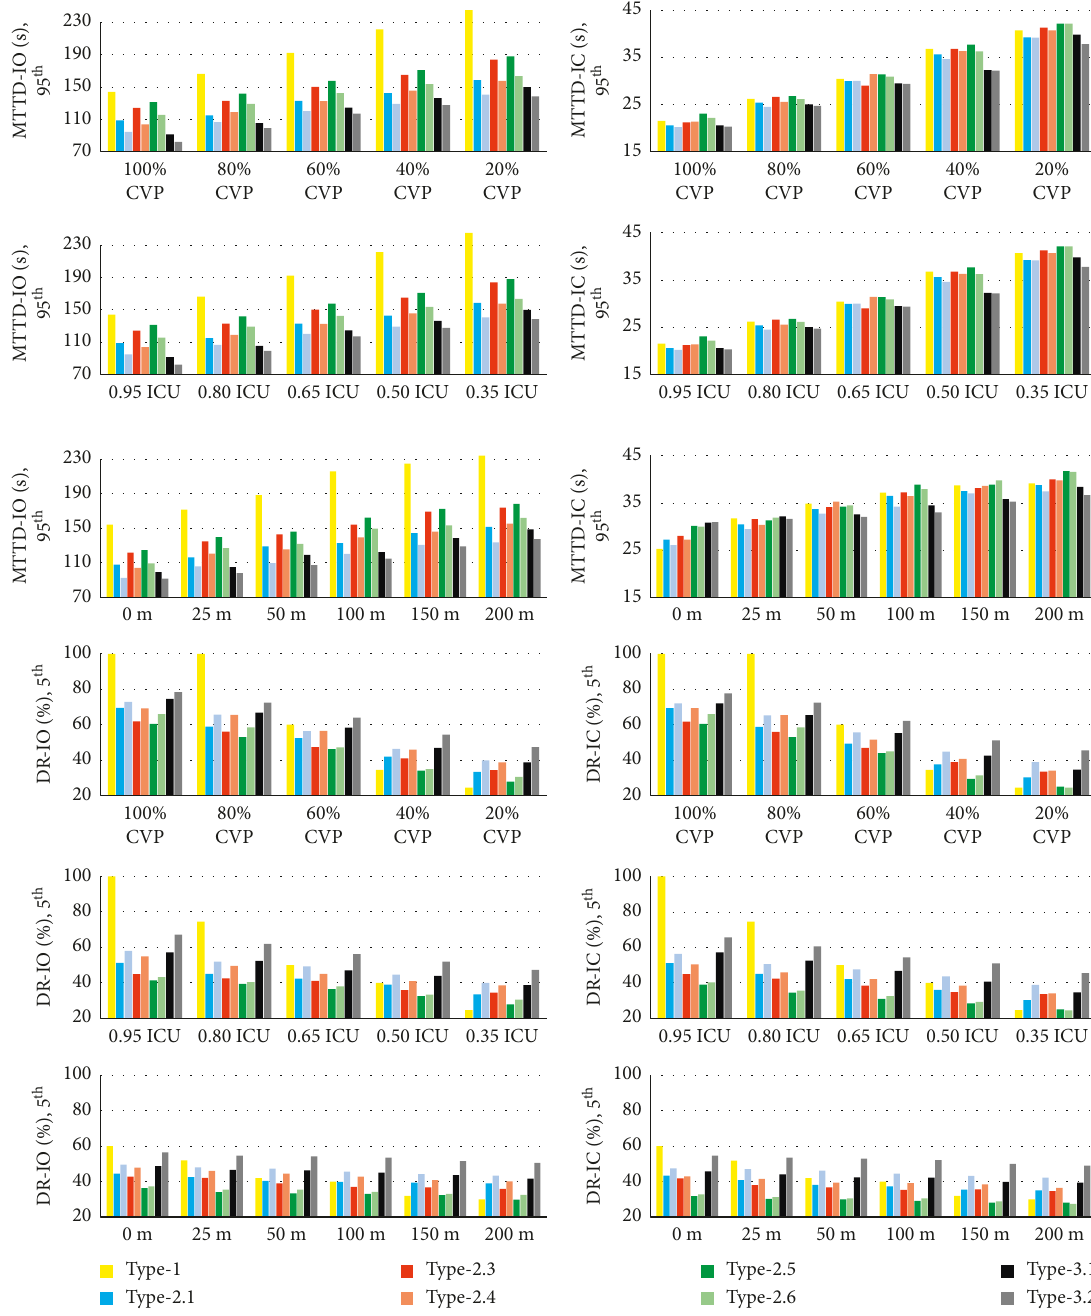
Figure 7: MTTD (95 th percentile) and DR (5 th percentile) comparison of all incident types at different CVPs, ICUs, and incident locations from the stop-line. Each bar represents an incident